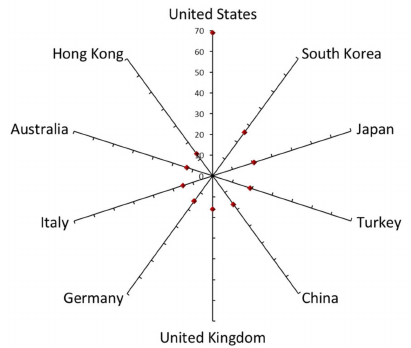
Figure 4. More productive countries in the generation of scientific literature on retinal nerve fiber thickness.